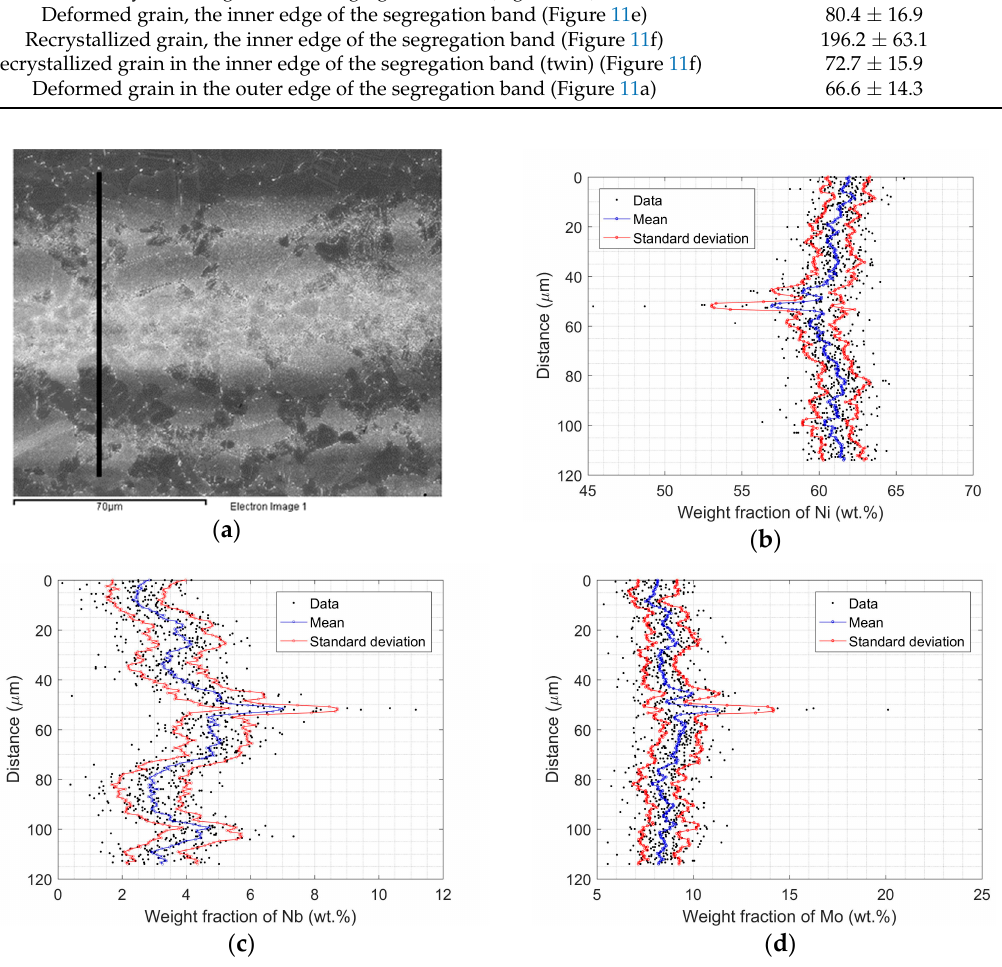
Figure 9. Different segregation bands with different distributions of the γ ’’ phase precipitate in the sample hot rolled at 1050 °C with the deformation level of 23.5% and aged at 750 °C for 25 h ( a ). Centered moving average (5 wide) and standard deviation of a 5 × 191 (3 µm wide and 127 µm long line) points in a line ( a ), for Ni K α ( b ), Nb L α ( c ) and Mo L α ( d ).